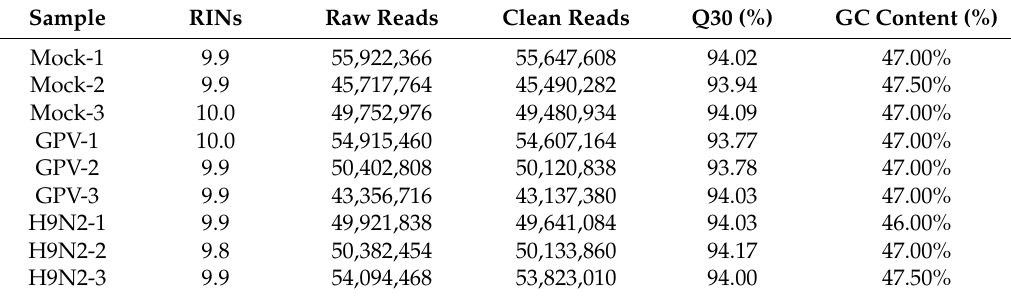
Table 1. Statistics of the RNA-seq